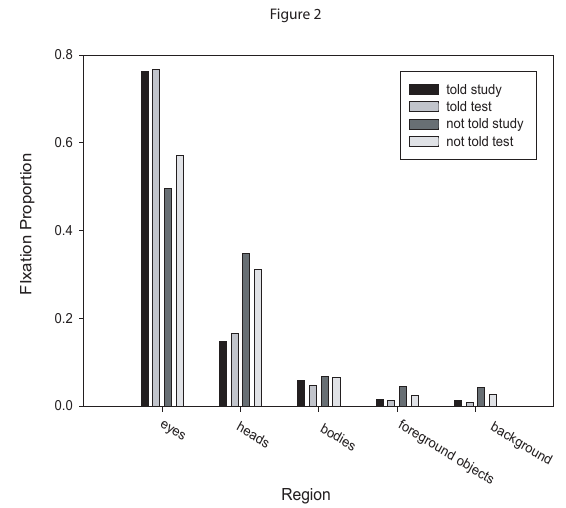
Figure 2. Area-normalized fixation proportions for the People scenes as a function of Instruction (Told, Not Told), Session (Study, Test), and Region (eyes, heads, bodies, foreground objects, background)